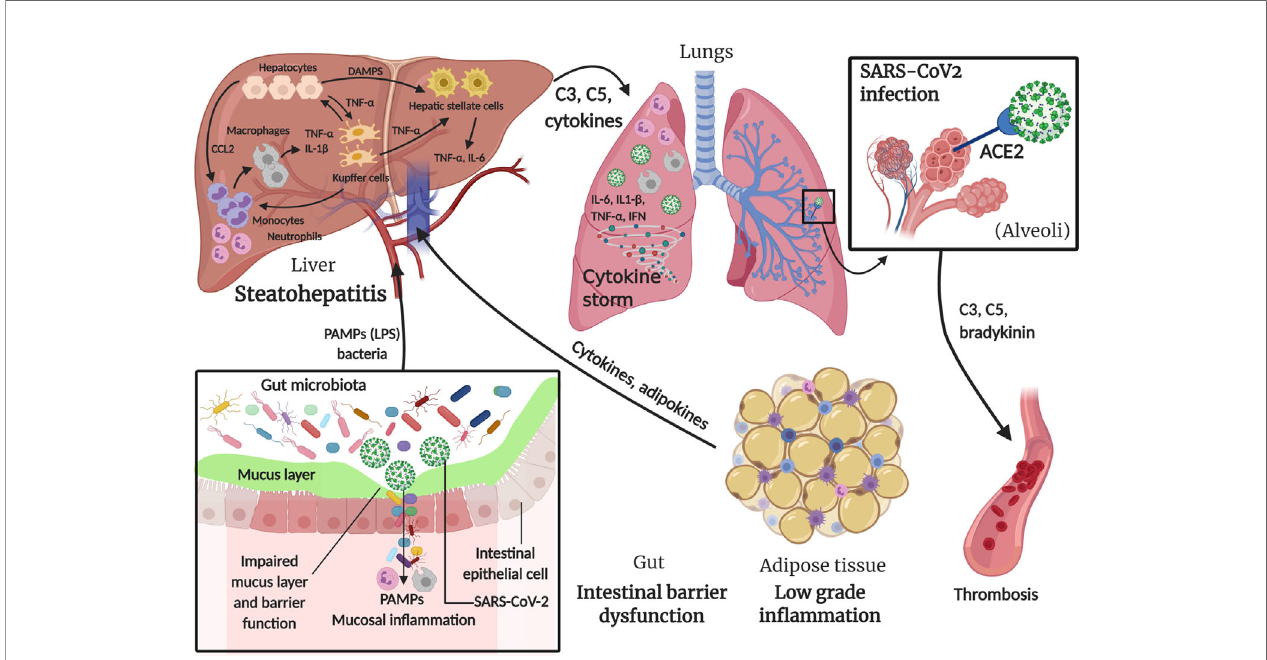
FIGURE 2 | Involvement of innate immune system in MAFLD and SARS-CoV-2 infection. In metabolic associated fatty liver disease (MAFLD), intestinal barrier dysfunction caused by intrinsic endotoxemia due to alterations in gut microbiota, adipose tissue low grade in fl ammation and the excess of fat in hepatocytes, lead to a series of events triggering the innate immune response in order to restore the perturbed environment. SARS-CoV-2 infection also contributes to intestinal mucosal in fl ammation, in addition to main lung in fl ammation caused by the virus entry through angiotensin-converting enzyme 2 (ACE2) in alveoli, which can also lead to thrombosis through a “ bradykinin storm ” . All these triggers lead to a massive “ cytokine storm ” with multiorgan effect. Created with